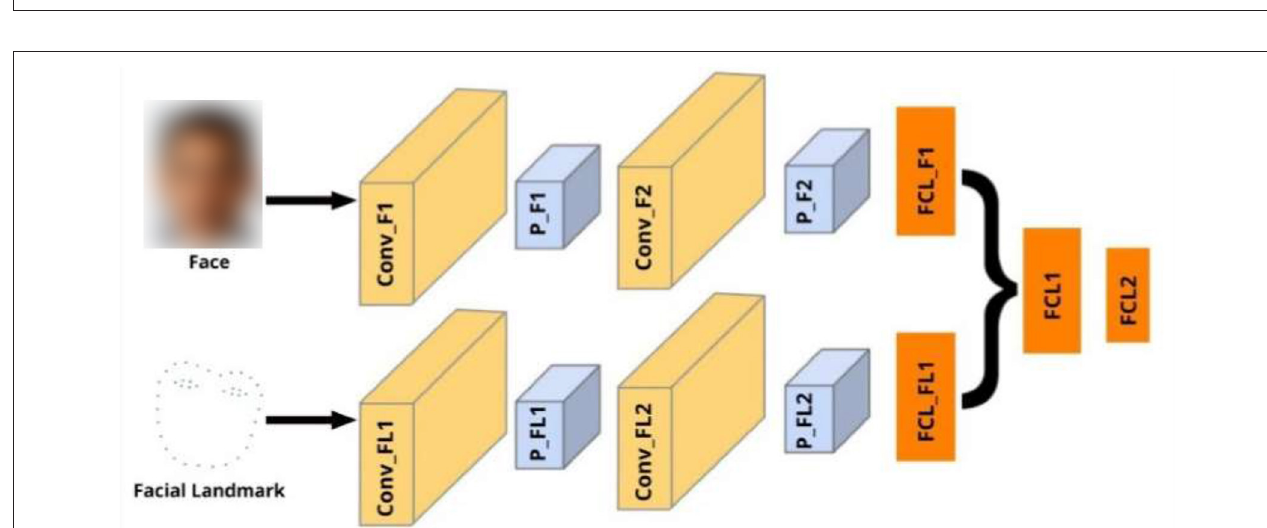
FIGURE 3 | Overview of the proposed technique. Inputs include face and facial landmark, all of size 224 × 224. Conv refers to convolutional layers, P represents pooling layer, FCL represents Fully Connected layers. FCL2 is the output layer.